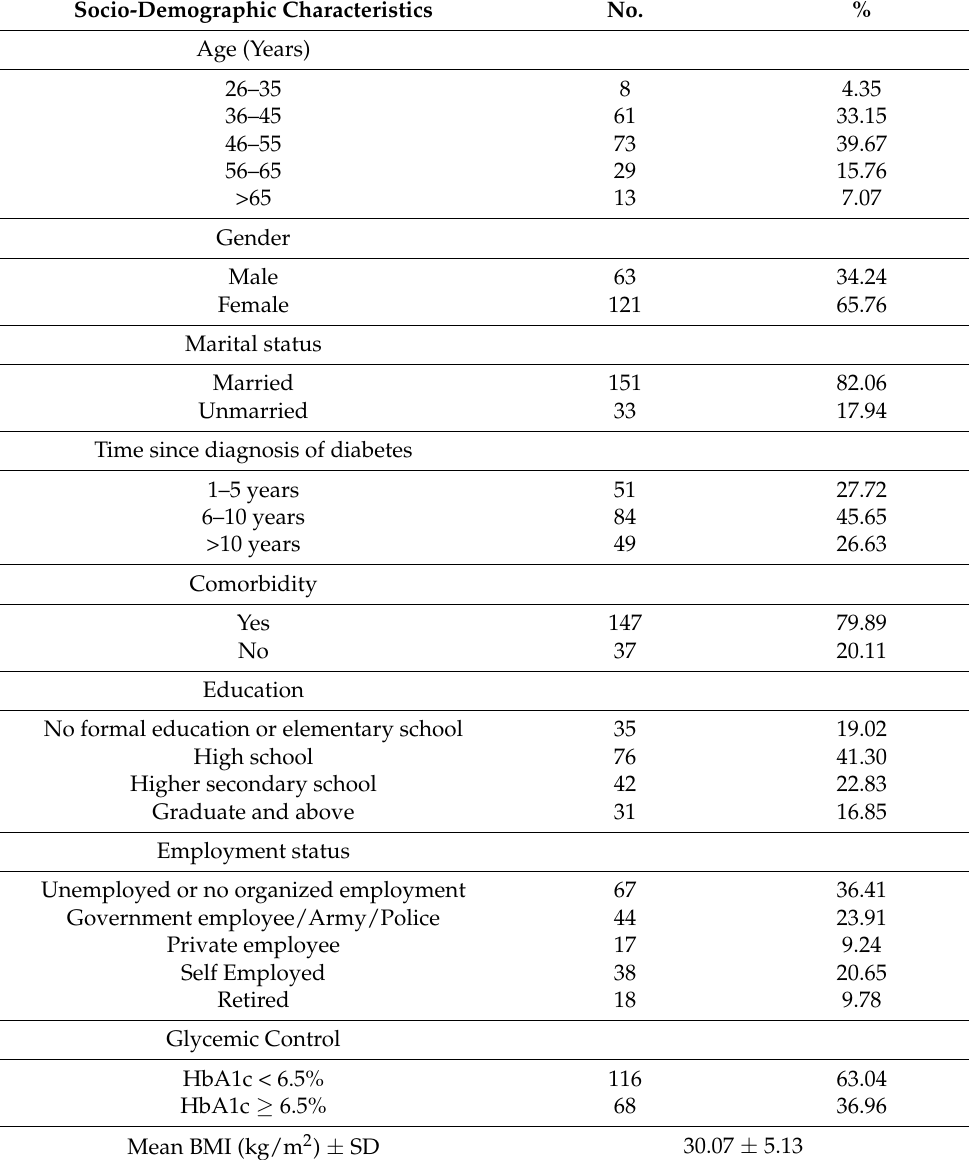
Table 1. Specifications of stories of building.